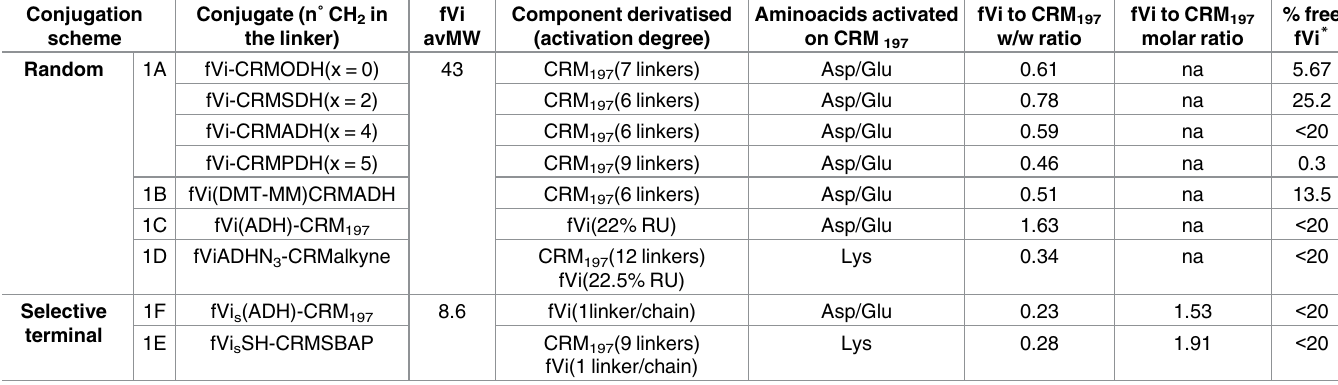
Table 3. Characteristics of the conjugates obtained using different conjugation strategies.